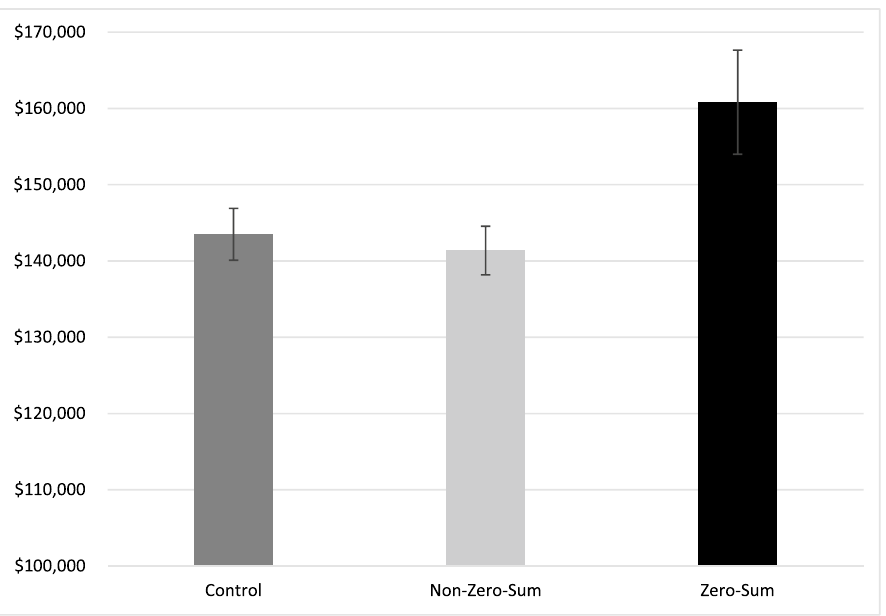
Figure 5. The base wage (i.e., salary) requirements of MBA students to work for the organization in each condition (Study 6). Errors bars represent standard errors